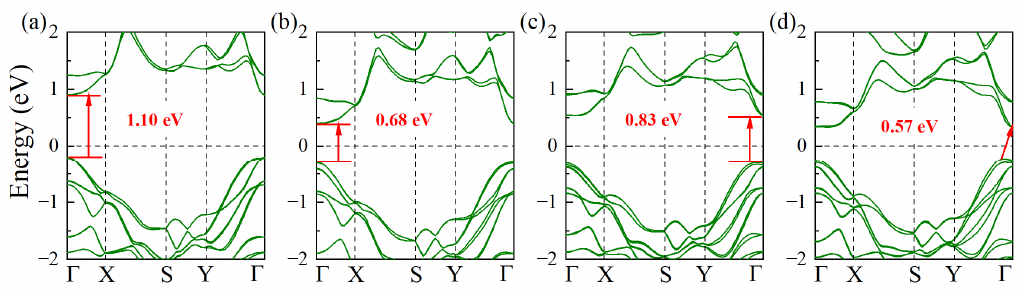
Figure 3. Band structures of monolayer: ( a ) CuSbS 2 ; ( b ) CuSbSe 2 ; ( c ) CuBiS 2 ; and ( d ) CuBiSe 2 at HSE 06 + SOC functional.